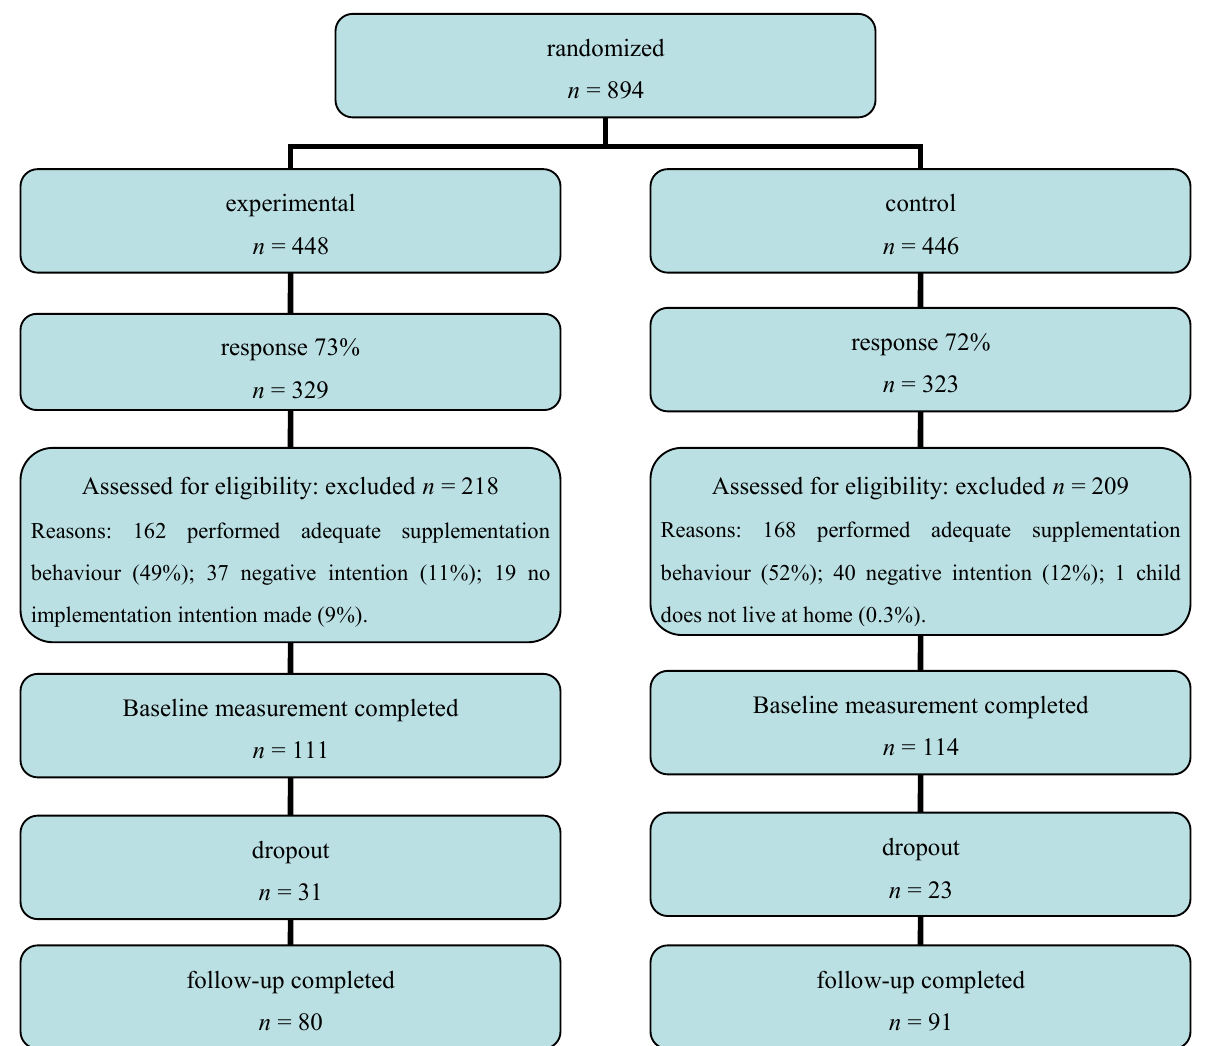
Figure 1. Flow of participants through the